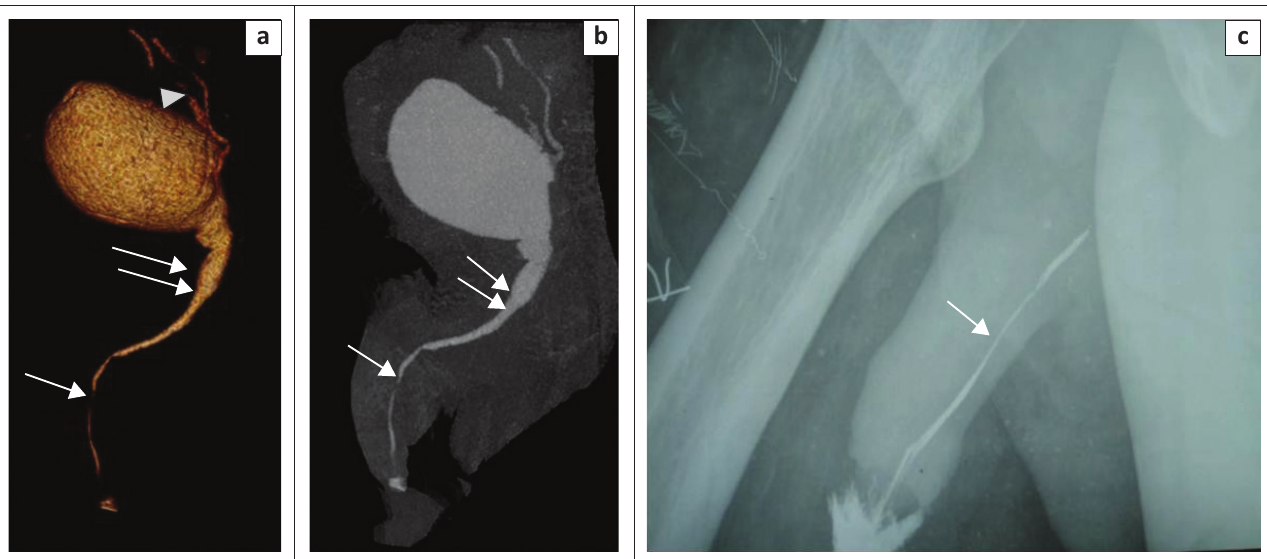
FIGURE 3: (a) Volume rendering technique image (multidetector computed tomographic urethrography [MDCTU]) showing a long-segment anterior urethral stricture (arrow) with adequate visualisation of the urinary bladder and posterior urethra (double arrows); both lower ureters (arrowheads) are opacified because of intravenous contrast administration. (b) Sagittal maximum intensity projection (MDCTU) showing the long-segment anterior urethral stricture (arrow) with adequate visualisation of the urinary bladder and posterior urethra (double arrows). (c) Retrograde urethrography image of the same patient indicating the long-segment anterior urethral stricture (arrow), with no passage of contrast into posterior urethra. Micturating cystourethrography could not be performed in this patient due to unsuccessful catheterisation.